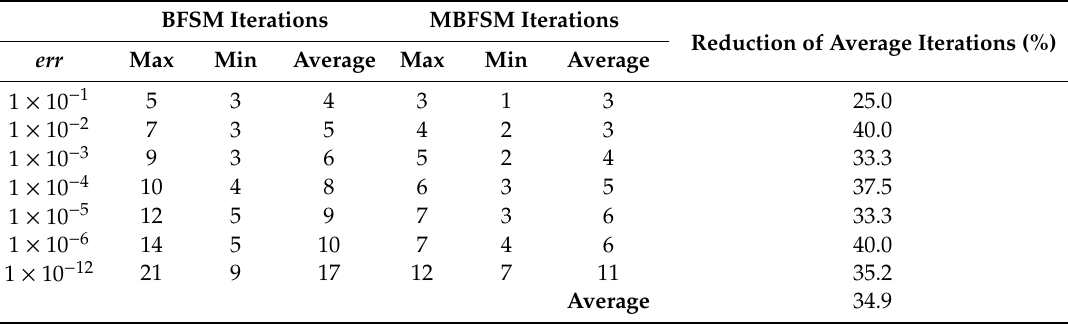
Table 3. Comparison of the computational e ff ort of solution